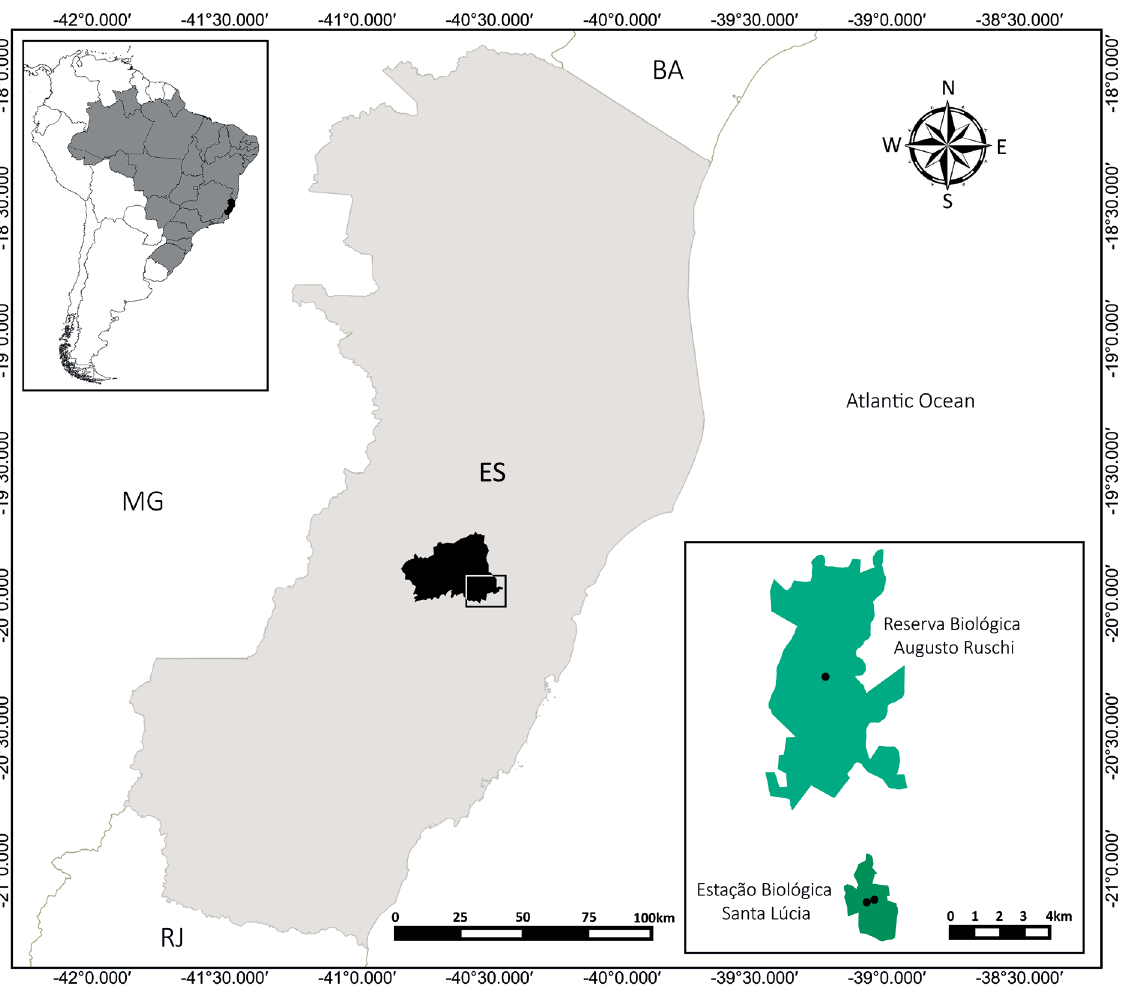
Figure 3 – Geographical distribution of Mollinedia ruschii , represented by black dots. The municipality of Santa Teresa is represented by the black shape. ES = Espírito Santo state; MG = Minas Gerais state; RJ = Rio de Janeiro state; BA = Bahia